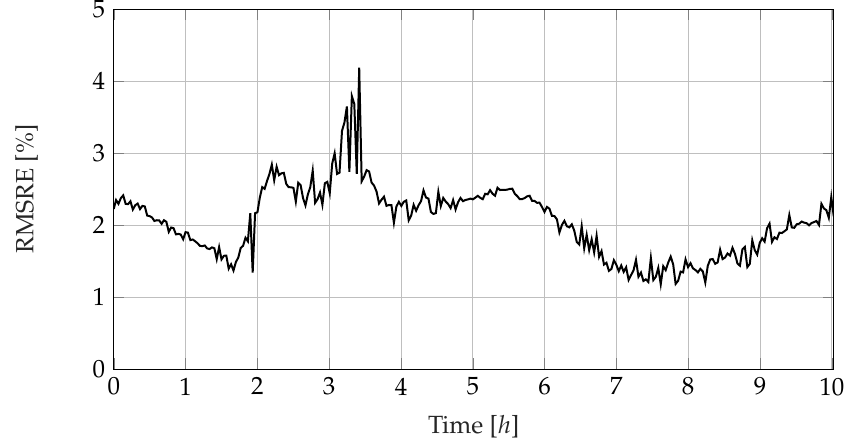
Figure 11. Course of the root mean squared relative error describing the difference between the fitted equivalent circuit model and the measured impedances. The outliers can be attributed to interferences in single measurement